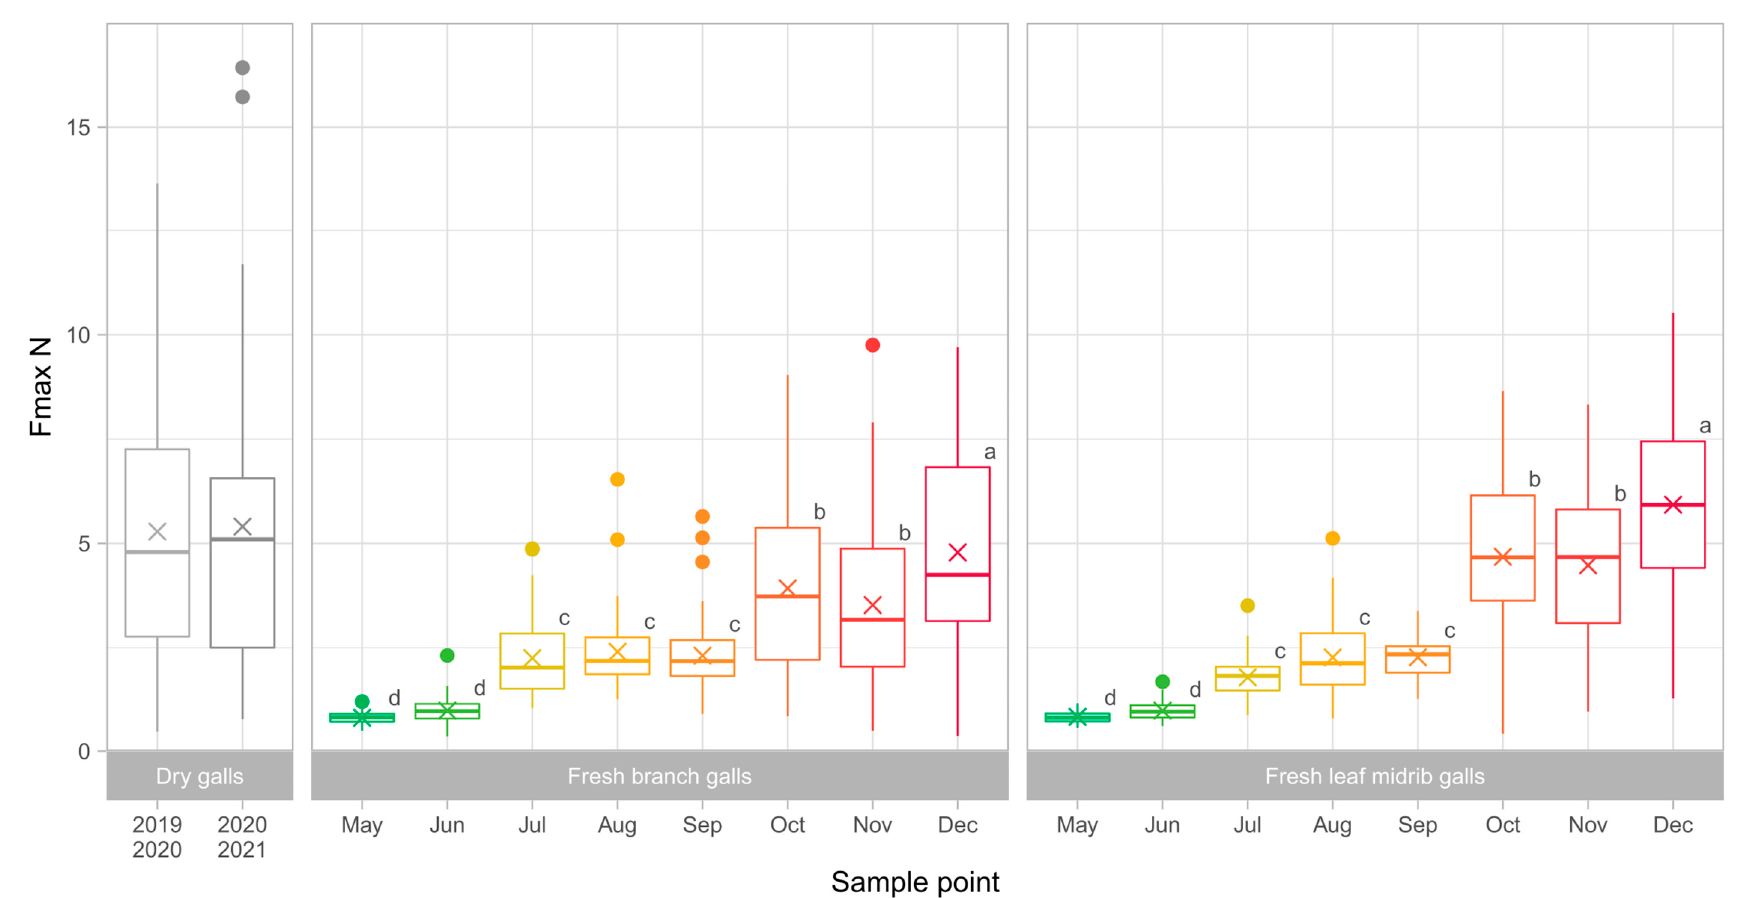
Figure 4. Maximum force (Fmax) recorded during the whole test, distinguishing between fresh branch and leaf midrib galls (N = 60). The multiplication sign ( × ) represents the mean value for each sample. Outliers were represented with colored points. Inside each sample type (dry galls, fresh branch galls, fresh leaf midrib galls), different letters evidence significant difference at p < 0.05 (Tukey HSD post-hoc test).